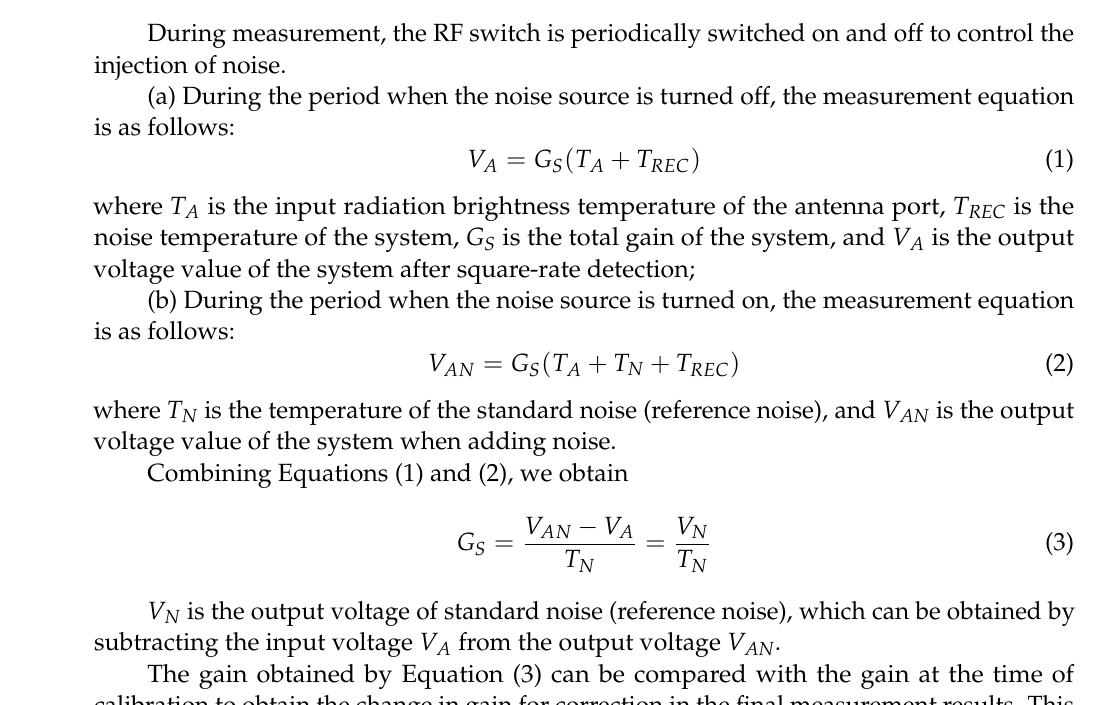
Figure 5. Block diagram of noise injection radiometer system.